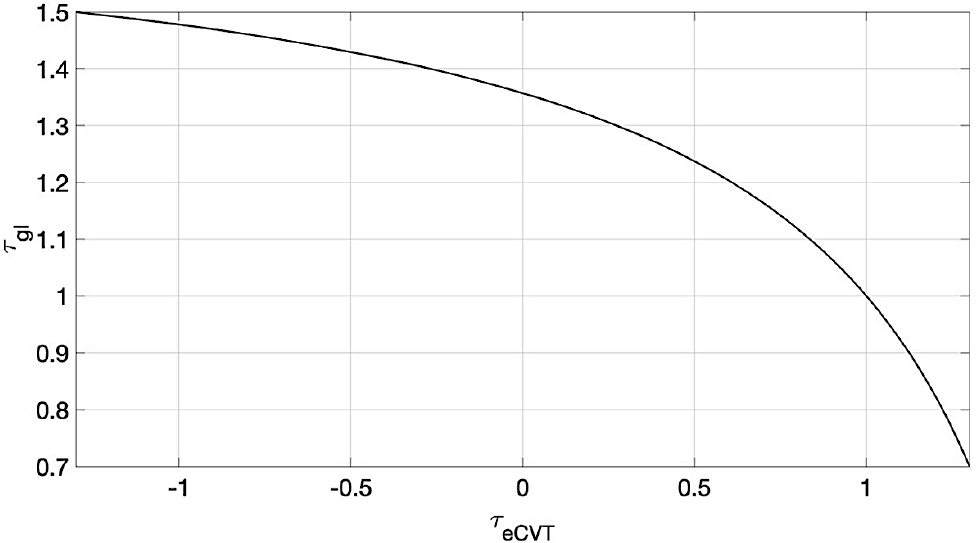
Figure 4. Global transmission ratio as a function of eCVT transmission ratio, given the input design parameters of Equations (28) and (29).